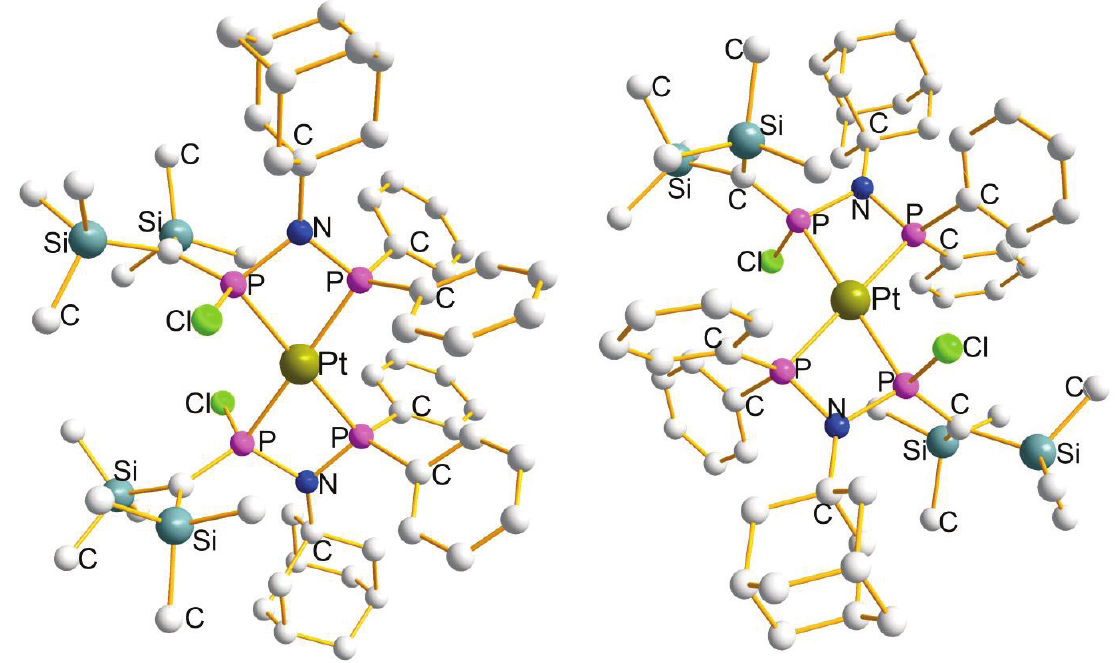
Figure 3: Structure of cis-anti- and triclinic trans-anti-[Pt{ η 2 -Ph